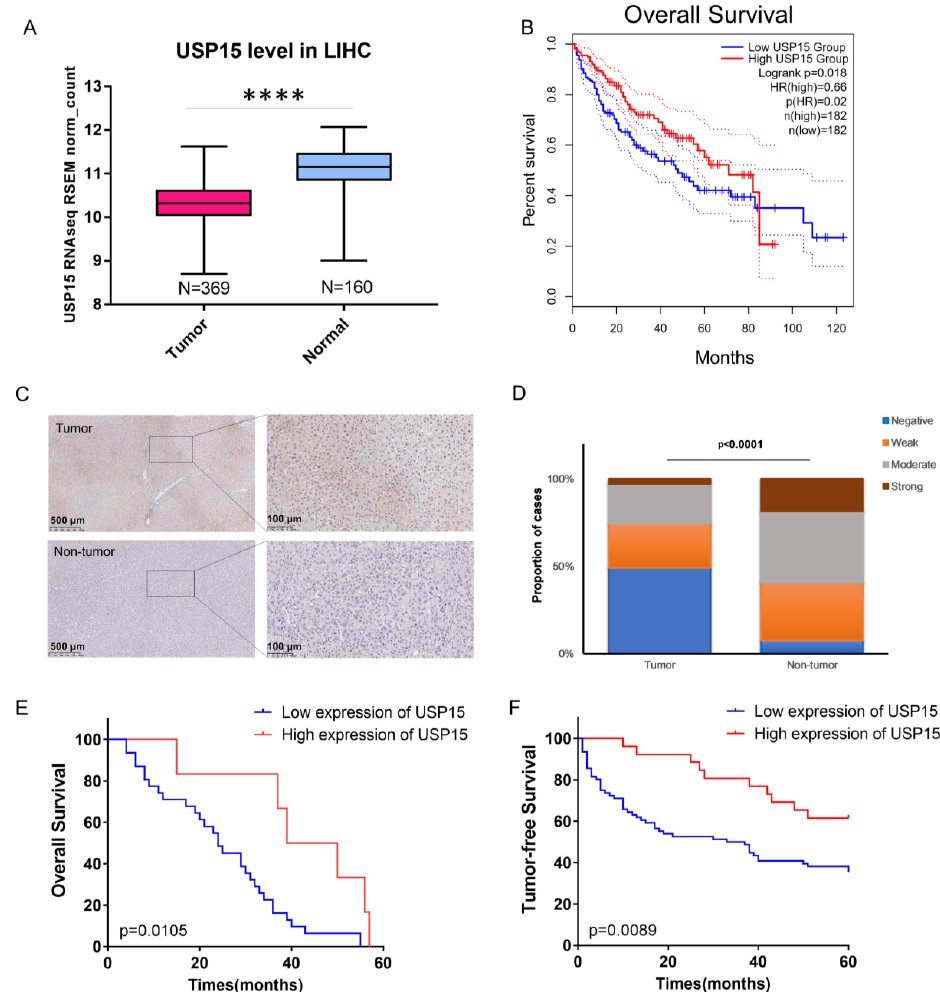
Figure 1. USP15 is down-regulated in hepatocellular carcinoma (HCC) tissue. High expression of USP15 in HCC patients is associated with significantly decreased risk for mortality and cancer relapse. ( A ) Box plots of USP15 expression in tumor and non-tumor tissue; liver hepatocellular carcinoma (LIHC) dataset of TCGA and GTEX. The median expression level of USP15 is lower in tumor tissue ( N = 369) than in non-tumor tissue ( N = 160). (****: p < 0.0001, Mann–Whitney U test). ( B ) Kaplan–Meier plots of patients in the LIHC dataset of TCGA with high expression of USP15 (red curve) and low expression of USP15 (blue curve). The dotted lines indicate a 95% confidence interval. High expression of USP15 is associated with significantly decreased risk for mortality: hazard ratio 0.6, p -value 0.018 (log-rank test). ( C ) Two exemplary images of tissue samples that were stained (IHC) for USP15. Right figures are blowups of a part of the left image, see rectangle. By visual inspection, two trained pathologists assigned tumor tissue samples of 102 patient to one of the two classes: high expression of USP15 ( n = 26, moderate or strong staining) and low expression of USP15 ( n = 76, negative or weak staining). T—tumor tissues; NT—para-HCC tissues. ( D ) Fractions of tissue samples that were assigned to four staining levels: negative, weak, moderate, and strong. Tumor ( n = 102) and non-tumor samples ( n = 27) have significantly different distributions ( p < 0.001, Mann–Whitney U test). ( E ) Kaplan–Meier plots for survival of patients with low expression ( n = 76, blue curve) and high expression ( n = 26, red curve). High expression of USP15 is associated with significantly decreased risk for mortality: hazard ratio 0.379, p = 0.0105 (log-rank test). ( F ) Kaplan–Meier plots for tumor-free survival of patients with low expression ( n = 76, blue curve) and high expression ( n = 26, red curve). High expression of USP15 is associated with significantly decreased risk for cancer relapse: hazard ratio 0.420, p = 0.0089 (log-rank